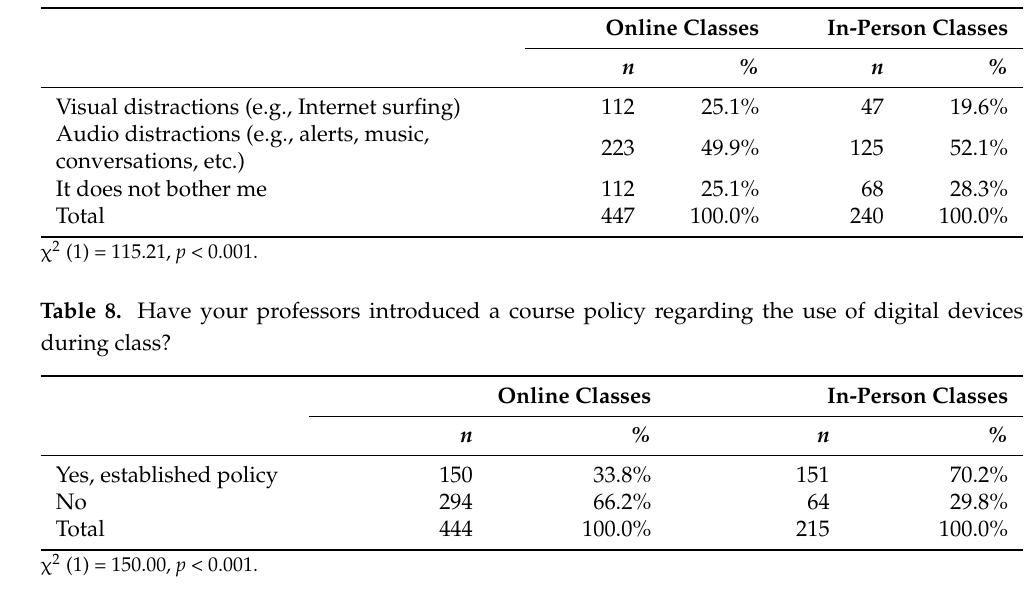
Table 7. What type of distraction bothers you the most during class?